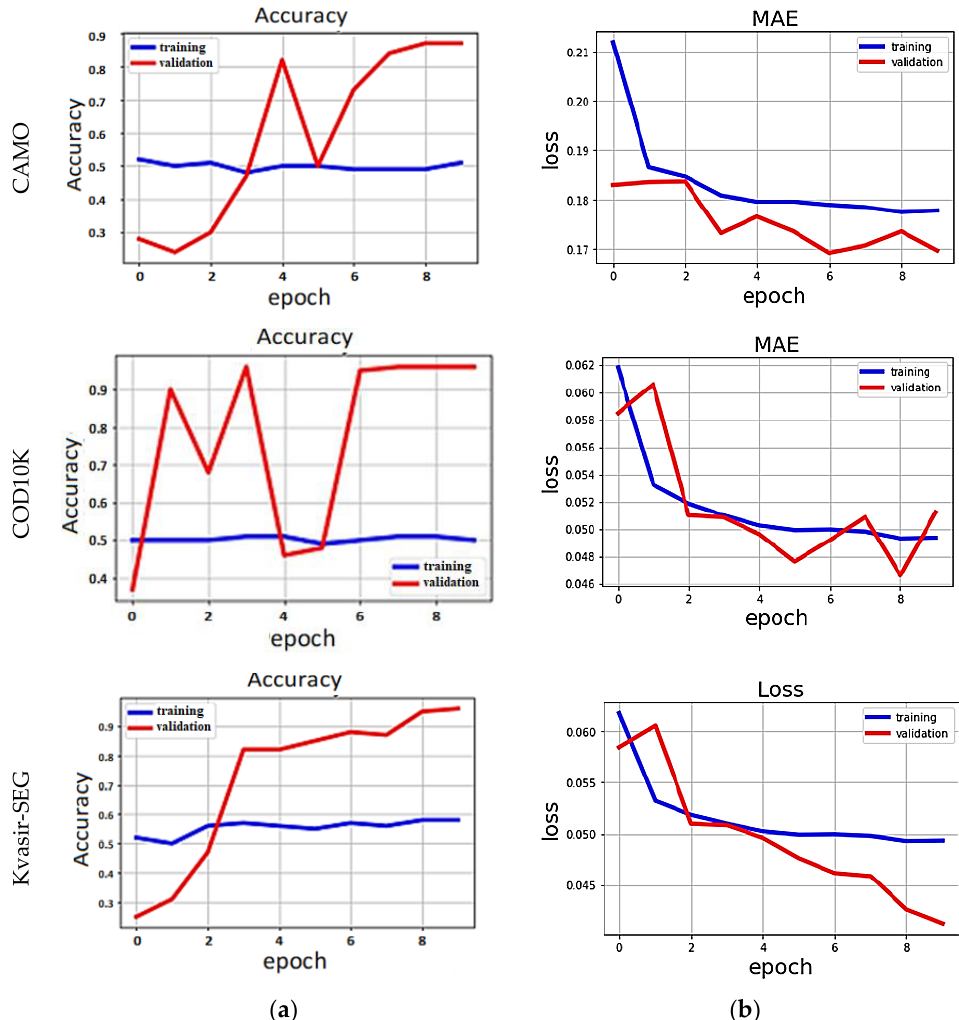
Figure 8. Training and validation graph on CAMO, COD10K, Kvasir-SEG on training and validation dataset: ( a ) binary accuracy; ( b ) mean absolute error